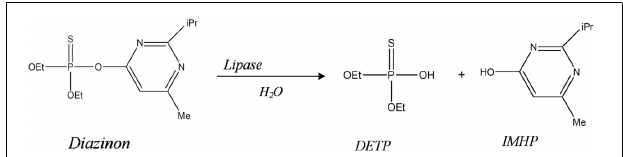
FIGURE 1 | Degradation pathway of diazinon by lipase (Hydrolysis